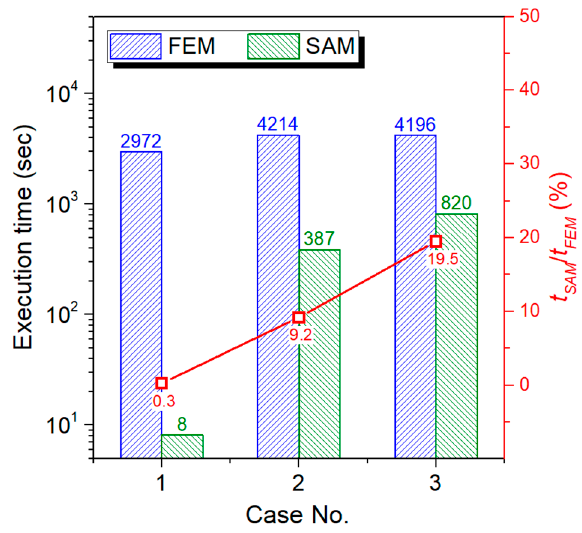
Figure 13. Comparison of execution time of FEM and SAM.